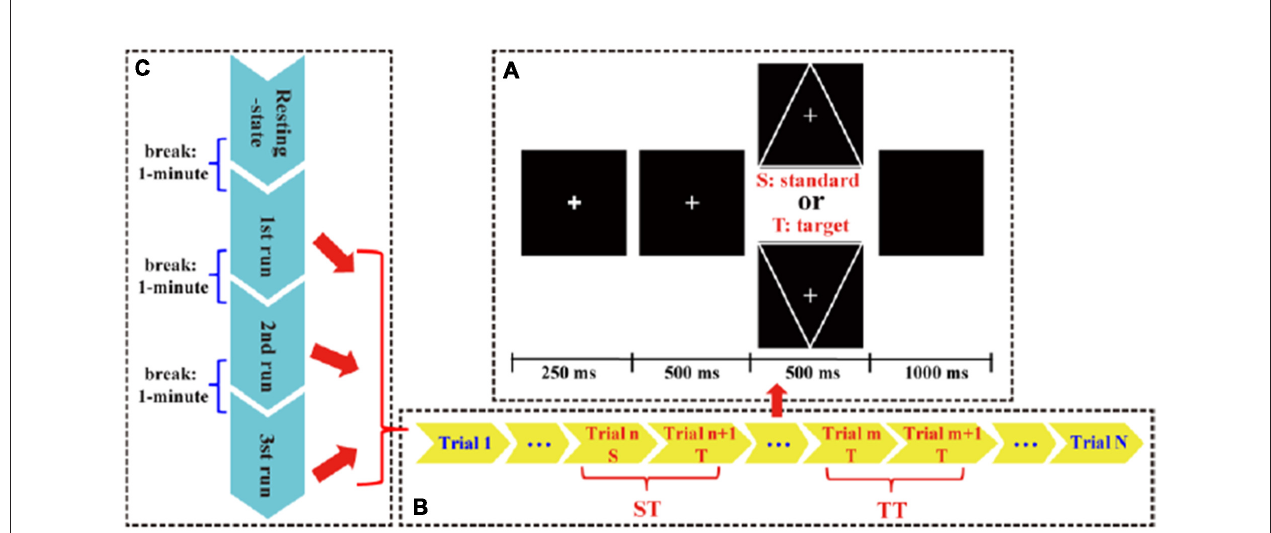
FIGURE 1 | The P300 protocol used in this study. (A) Each trial consisted of an alert of attention (250 ms), a cue of preparation (500 ms), a target (T) or standard (S) stimulus (500 ms), and a short black screen (1,000 ms). (B) Each run consisted of 150 S/T stimuli. (C) Whole P300 task consisted of three runs.